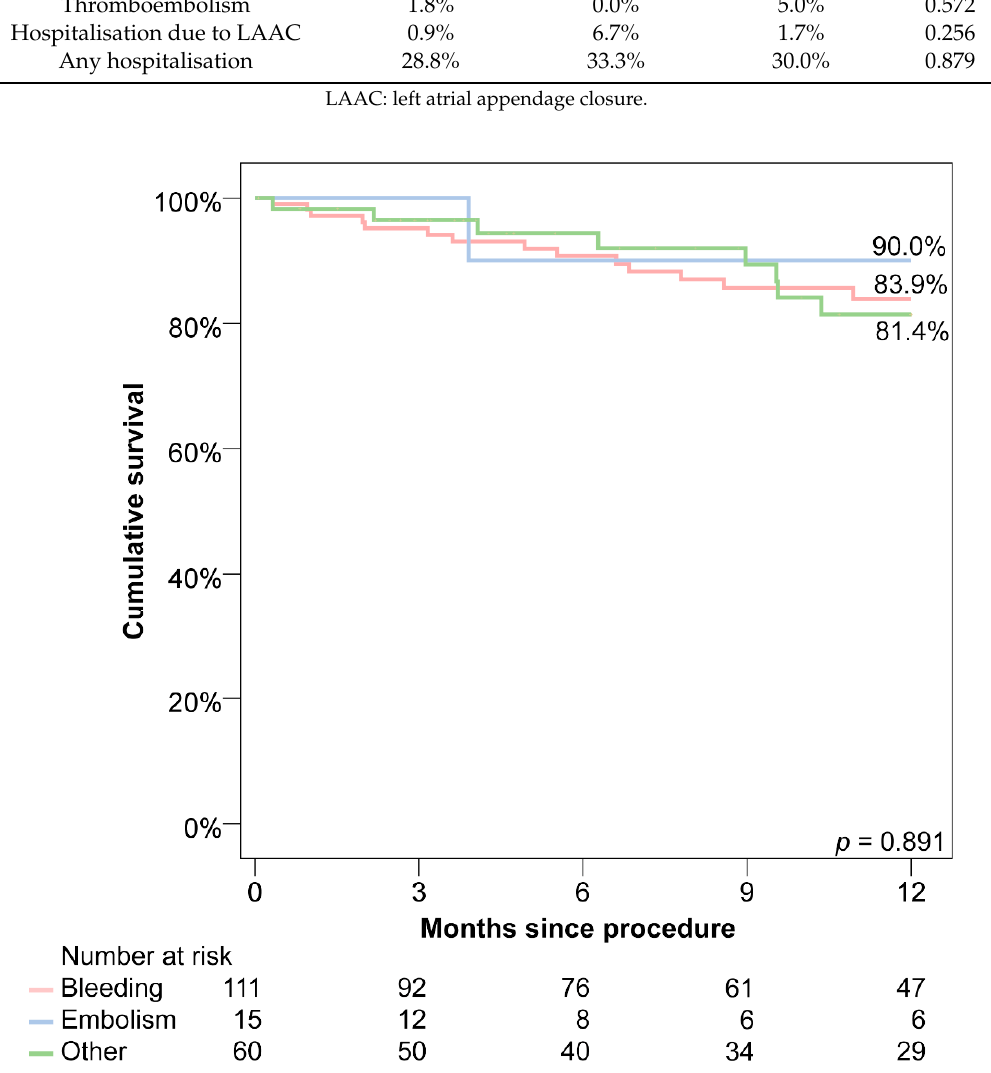
Figure 3. Kaplan-Maier curves for the combined endpoint of death, stroke, bleeding or LAAC-related rehospitalisation.